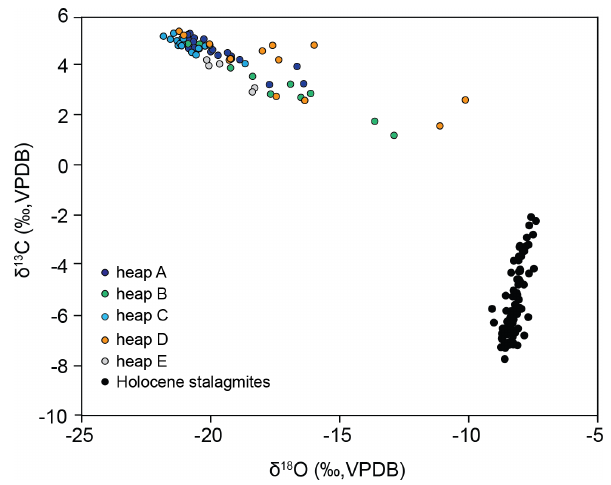
Figure 2. Stable isotope composition of CCC from Cioccherloch Cave. Samples from different CCC heaps are colour-coded. Values of two Holocene stalagmites from the same cave gallery are shown for comparison (unpublished data by the